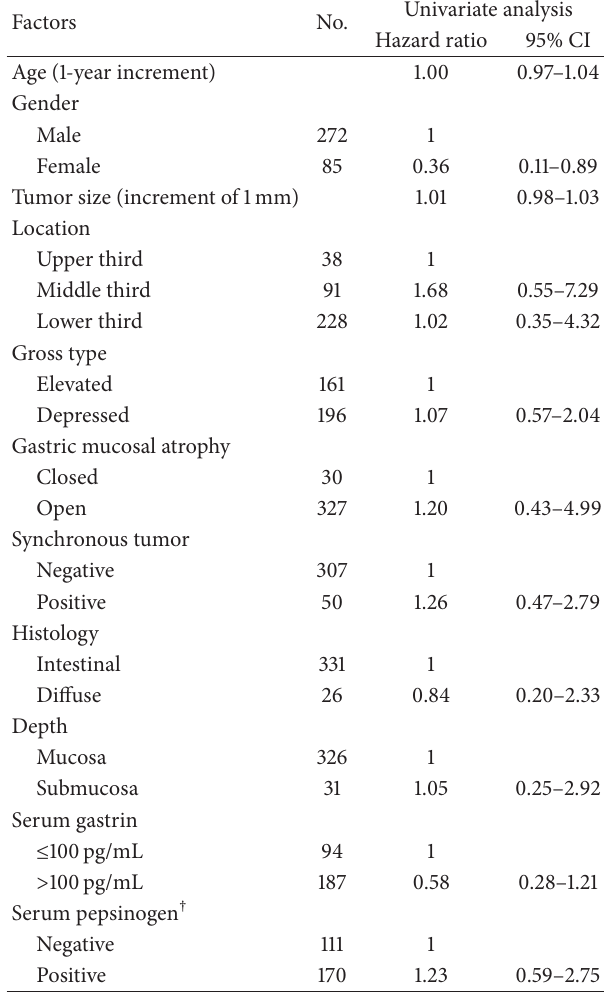
CI: confidence interval. † Serum pepsinogen-positive: PG I ≤ 70ng/mL and PG I/II ≤